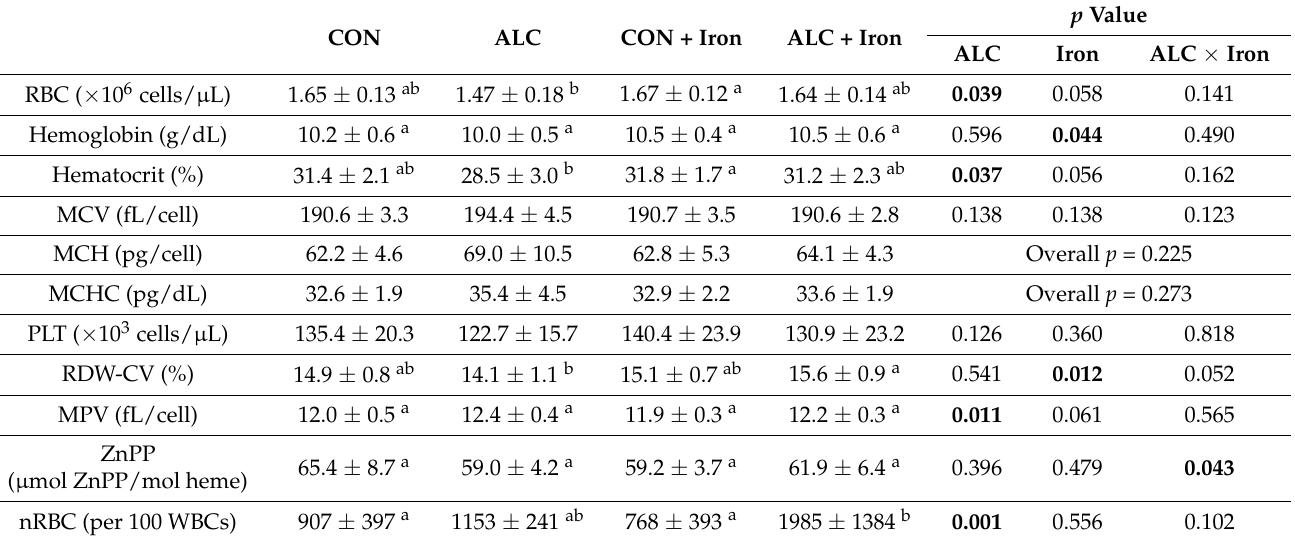
Table 5. Alcohol exposure caused fetal anemia which iron supplementation resolved.